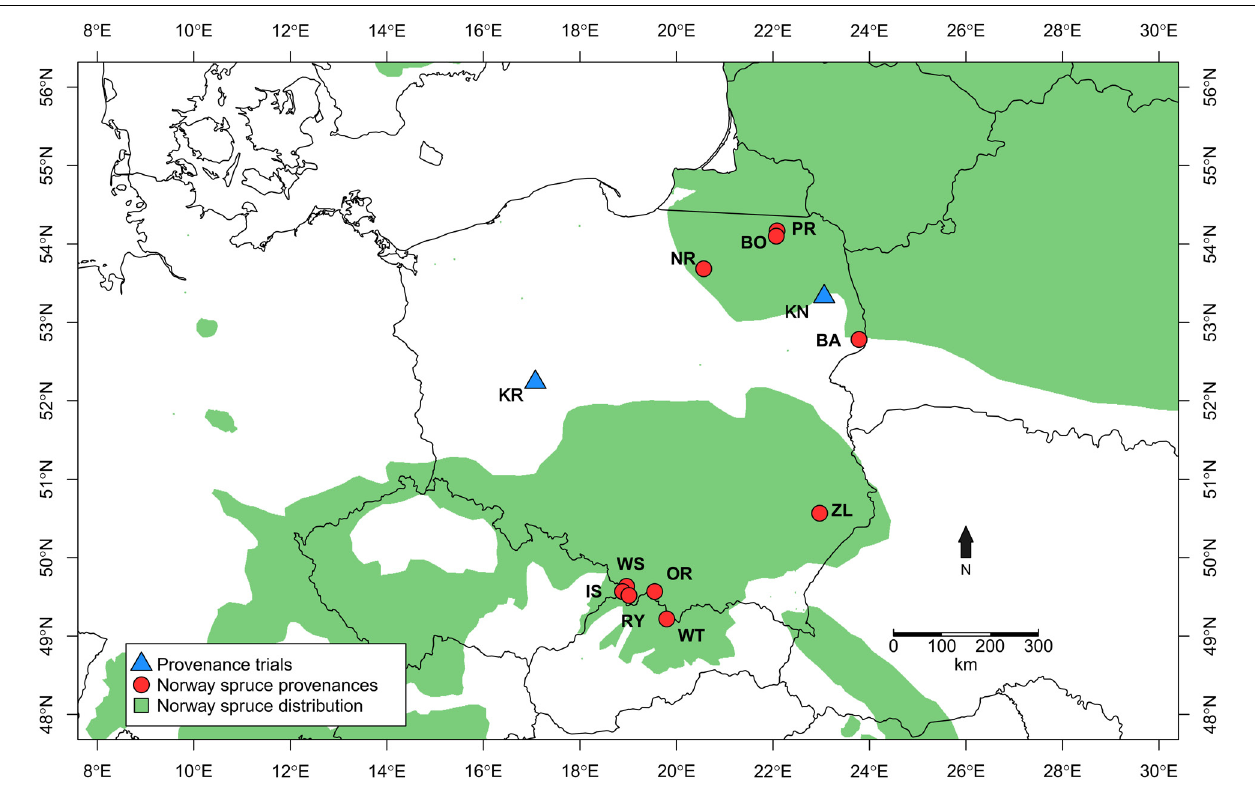
FIGURE 1 | Location of study sites. Blue triangles – experimental sites, red circles – Norway spruce provenances. KR, KN – Kórnik and Knyszyn testing site; BA, BO, PR, NR, IS, WS, RY, OR, WT, and ZL Norway spruce provenances; green area – natural distribution area of Norway spruce (European Forest Genetic Resources Programme [EUFORGEN],